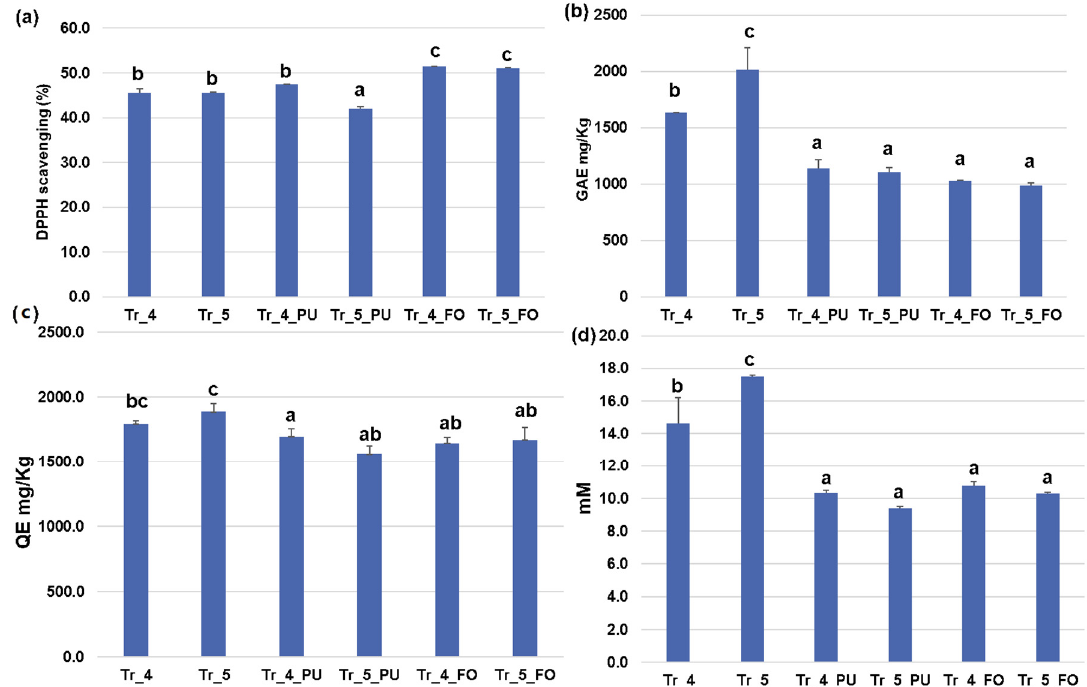
Figure 9. Antioxidant activity of leaf extracts of pepper plants grown in soil amended with the functional SCG composts carrying Streptomyces sasae St-3 and infected with root rot plant pathogens Fusarium oxysporum f. sp. lactucae (KACC 42795) (FO) and Pythium ultimum (KACC 40705) (PU). The tests included ( a ) DPPH scavenging activity, ( b ) total phenolic content (TPC), ( c ) total flavanoid content (TFC), and ( d ) Trolox equivalent antioxidant activity (TEAC). Letters above the error bar indicates the comparison of samples using Duncan’s